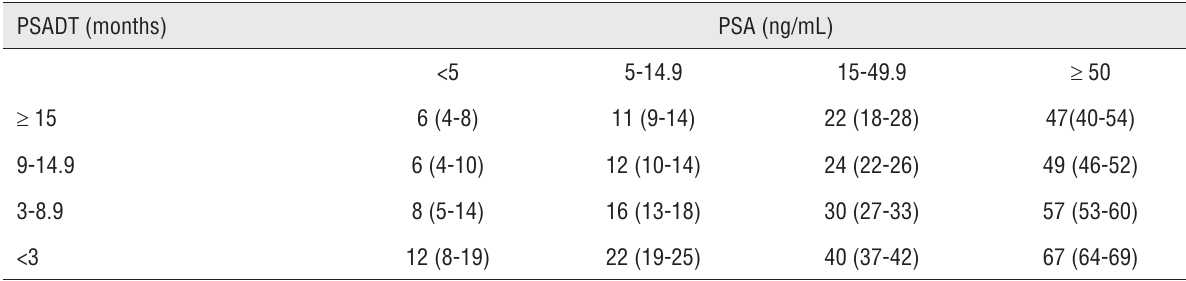
Table 4 - Moreira et al. (11) Predicted risk of positive scan by PSA and PSADT groups.